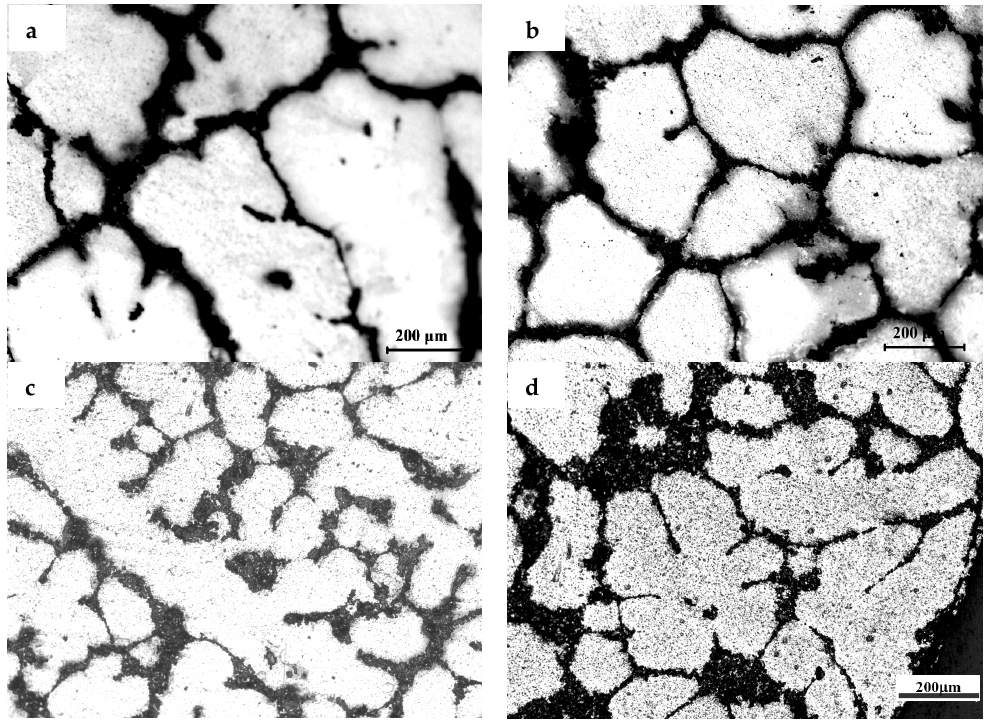
Figure 4. The microstructures of TiB 2 /7075 composites with cooling rate of 1 °C/min. ( a ) 3.0% TiB 2 /7075; ( b ) 4.5% TiB 2 /7075; ( c ) 6.0% TiB 2 /7075; ( d ) 9.0% TiB 2 /7075.